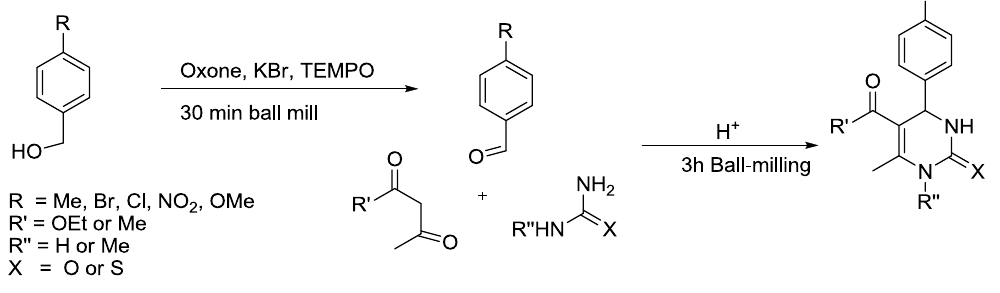
Scheme 34. Multicomponent Biginelli reaction.